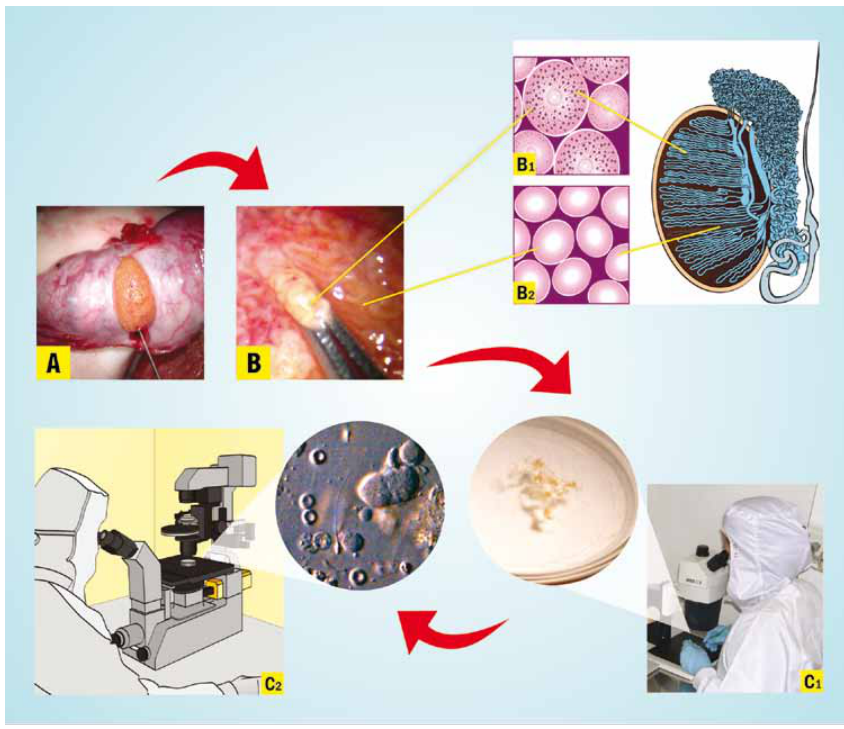
Figure 3 - Microsurgical Testicular Sperm Extraction (Micro-TESE). Operating microscope and microsurgical technique are used throughout the procedures. After testis exteriorization, a single and large incision is made in an avascular area of the albuginea to expose testicular parenchyma (A). Microdissection of seminiferous tubules is carried out to identify and remove large tubules that are most likely to contain germ cells and active spermatogenesis. A photograph taken at x40-magnification indicates enlarged and non-enlarged seminiferous tubules (B). Enlarged tubules may contain active spermatogenesis, as illustrated in the transversal section of a histopathology specimen (B1). Non-enlarged tubules are more likely to contain no active spermatogenesis (B2). Excised testicular specimens are sent to the laboratory for process - ing and examination. Seminiferous tubules are mechanically dispersed using needled-tuberculin syringes (C1). Testicular homogenates are microscopically examined to confirm the presence of spermatozoa